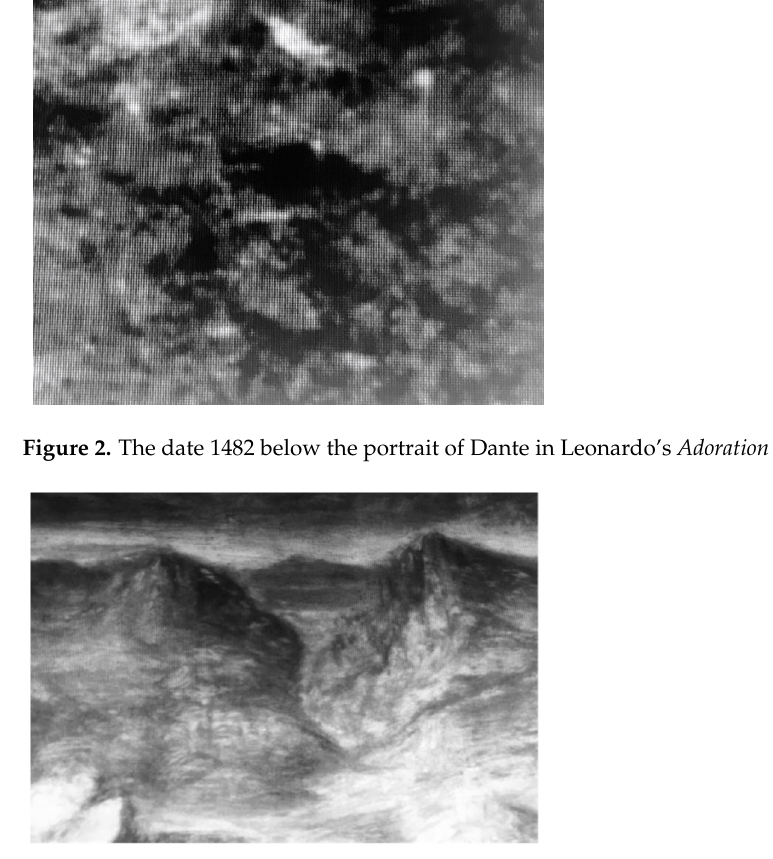
Figure 3. In the background landscape of the Mona Lisa , these giant hands appear to rescue the citizens of Florence in the great flood of 1333, which killed over 3000 people. However, looking more closely, we discover that the hands belong to some infernal Moloch who is about to devour the survivors. Floating corpses and skeletons and the top of the submerged Torre d’Arnolfo are visible in the water below the hands.